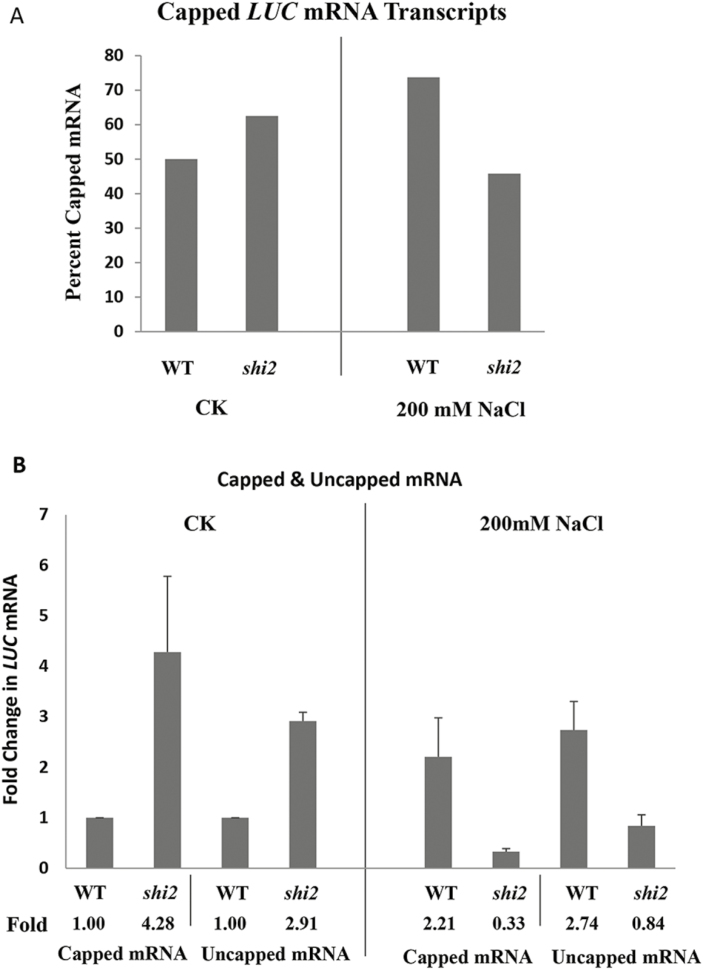
The shi2 mutation alters the capping pattern of the LUC mRNA. (A) Quantification of 5' capping of LUC mRNA using 5' RACE. The 5' cap was determined by the presence of a G at the very 5' end of the cDNA, which is not a genomic nucleotide in the LUC gene at this position. (B) Detection of 5' capping of LUC mRNA using the cap-binding protein eIF4E. The levels of capped and uncapped mRNAs were determined by RT–qPCR. Data are means ±SD (n=3). The salt treatment was 200 mM NaCl for 5 h.